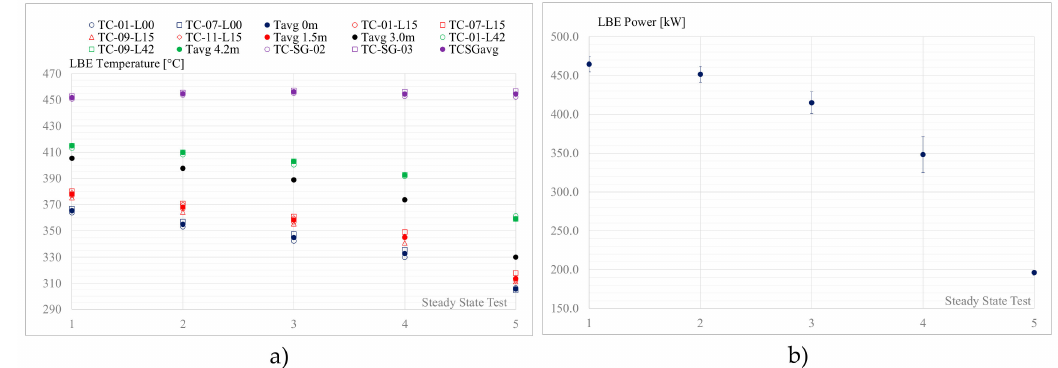
Figure 5. EF-T1: ( a ) LBE temperatures along the SG shell side for all the steady states; ( b ) LBE power and relative standard deviation at steady states.